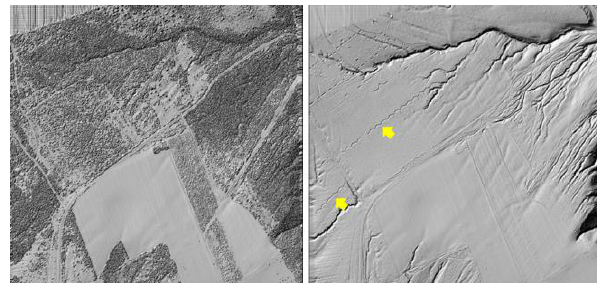
Figure 9. The Digital Surface Model (left) and the Digital Elevation Model (right) with the trenches (arrows) in Bükk National Park area